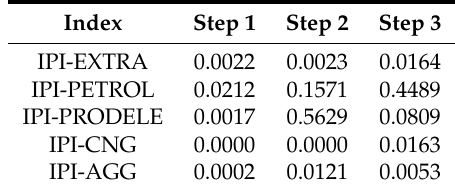
Table 33. Modified Diebold–Mariano statistics for the equality of forecast accuracy of two forecasts under general assumptions with an expanding window from 2015:01 to 2018:12. The null hypothesis is that the two methods have the same forecast accuracy. The loss function is the squared error.